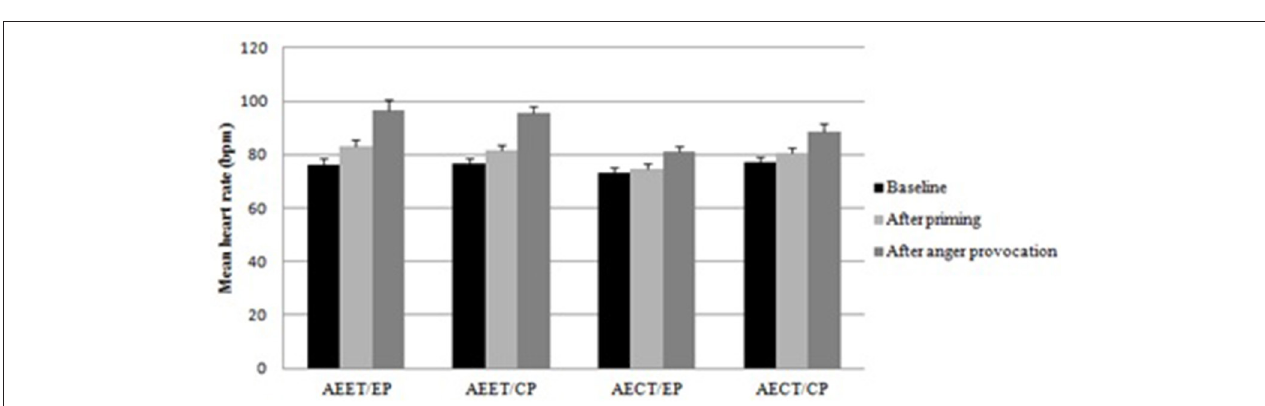
FIGURE 3 | Mean of heart rate for the four groups (AEET/EP, automatic emotion expression tendency/expression priming; AEET/CP, automatic emotion expression tendency/control priming; AECT/EP, automatic emotion control tendency/expression priming; AECT/CP, automatic emotion control tendency/control priming) across the three measurement points (baseline, after priming, after anger provocation; error bars represent standard errors of the mean).